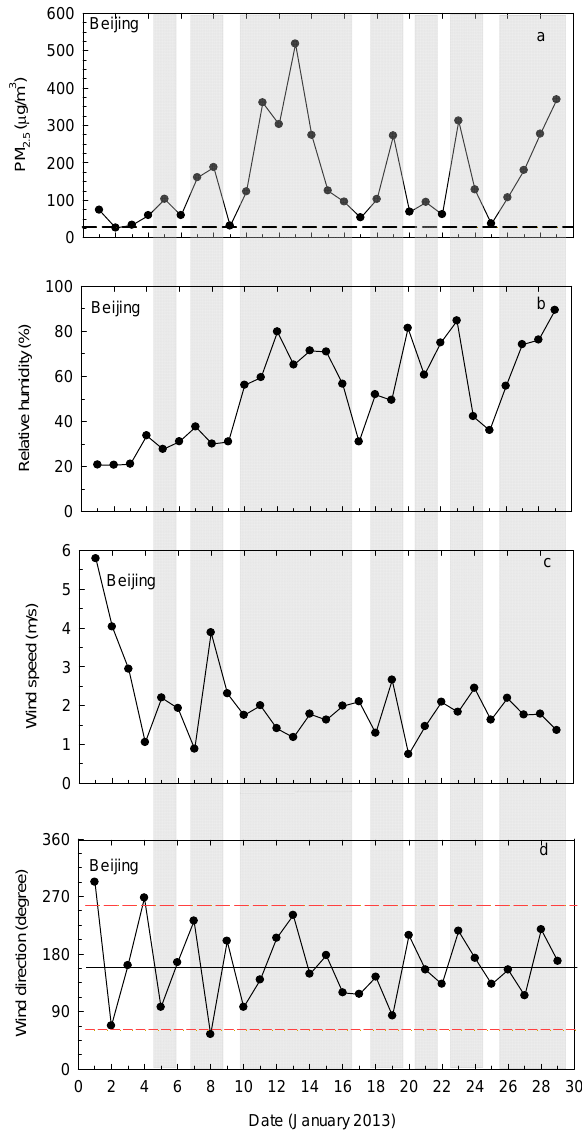
Fig. 2. Daily averaged PM 2 . 5 (the dashed line indicates 75µgm − 3 ) (a) , relative humidity (b) , wind speed (c) , wind direction (the upper red dash line indicates the wind from west and the bottom one indi- cates the wind from east) (d) at Beijing. The shaded area indicates daily PM 2 . 5 exceeding 75µgm − 3